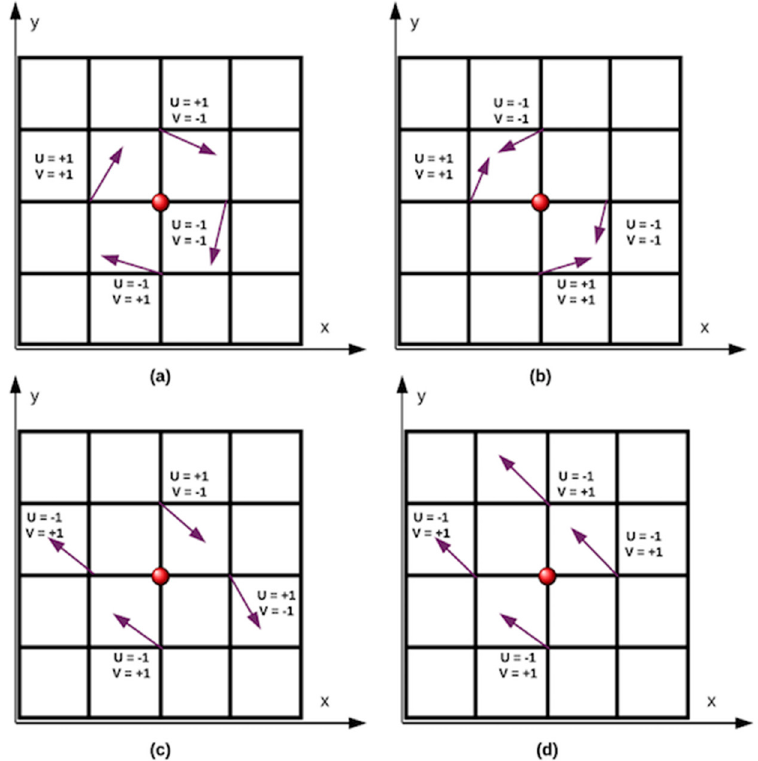
Figure 5. Four potential scenarios might be found near the potential cyclone eye in the Northern Hemisphere: ( a ) rotation wind; ( b ) strain wind; ( c ) shearing wind; ( d ) same direction wind.